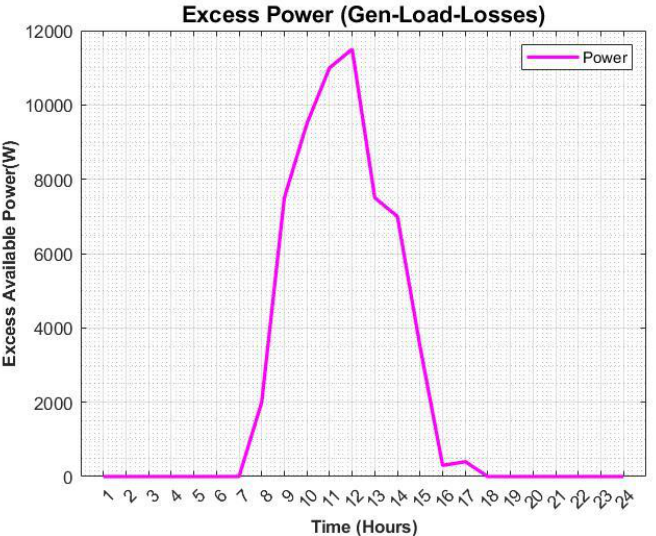
Figure 10. Excess power available after feeding the DS and charging batteries .